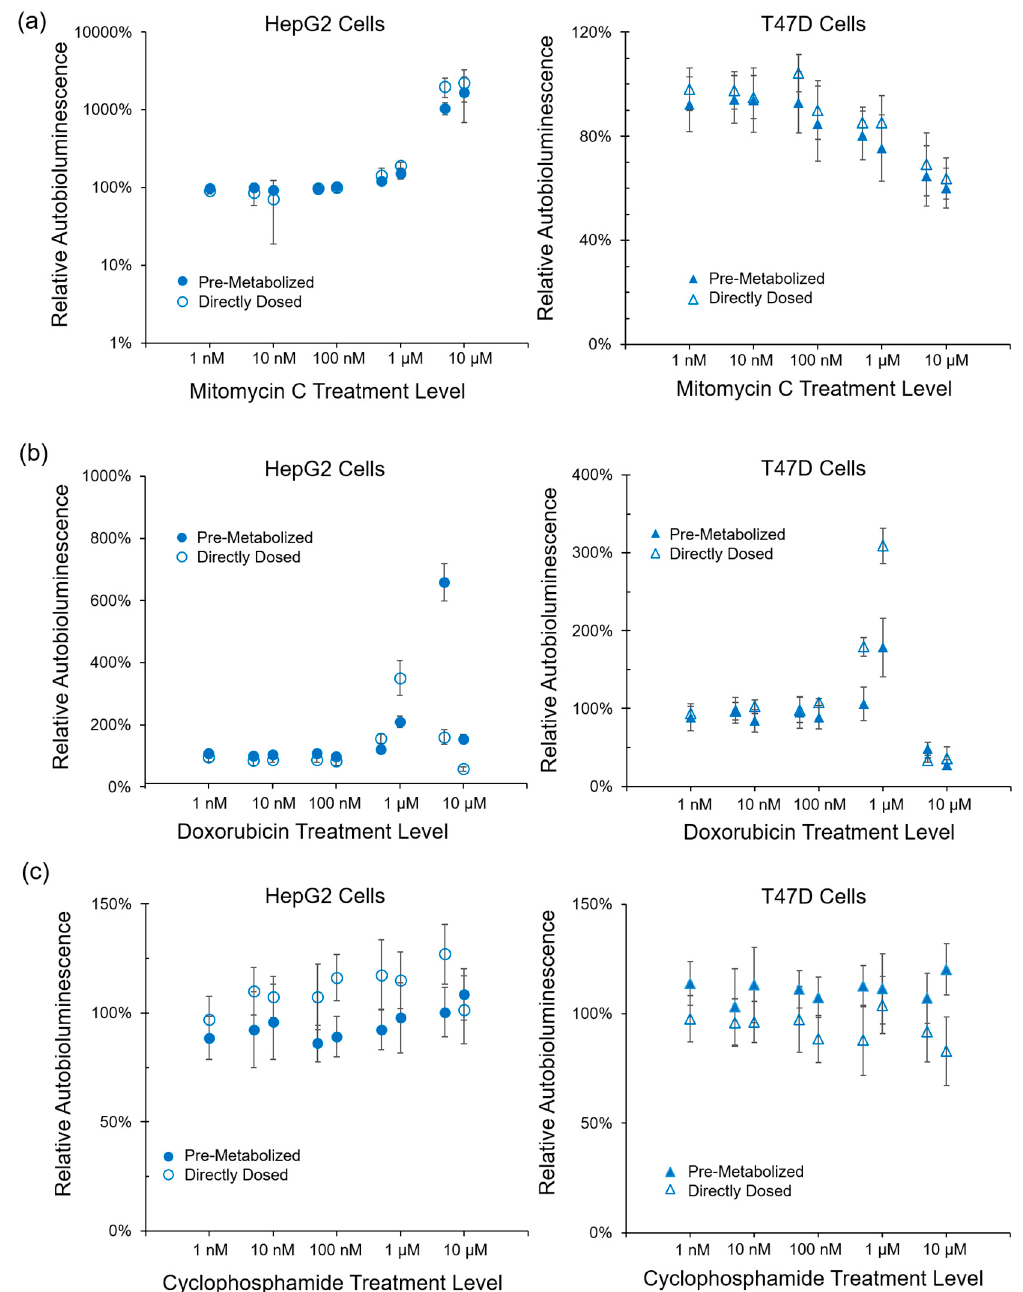
Figure 1. Autobioluminescent cells successfully detected both pre- and post-metabolized prodrug metabolic impacts from ( a ) the known cytotoxic compounds Mitomycin C and ( b ) Doxorubicin hydrochloride. ( c ) Treatment with Cyclophosphamide, which is known to become metabolically active only after liver cell metabolism, showed metabolic effects in the downstream human breast cancer (T47D) cell line, but not the upstream liver cancer (HepG2) cell line. Values are the averages of triplicate tests, with error represented as the standard error of the mean (SEM).